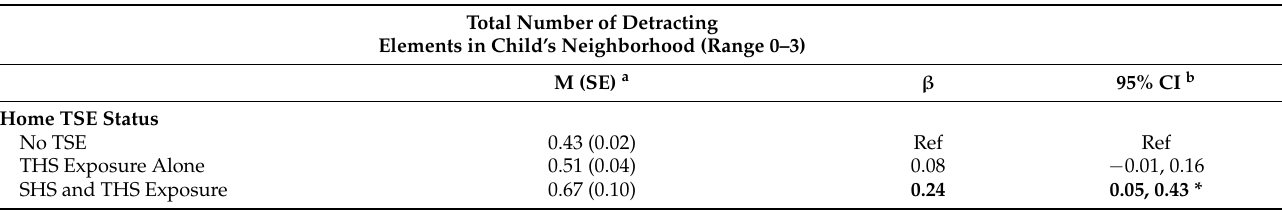
Table 4. Child home TSE status and total number of detracting neighborhood elements among